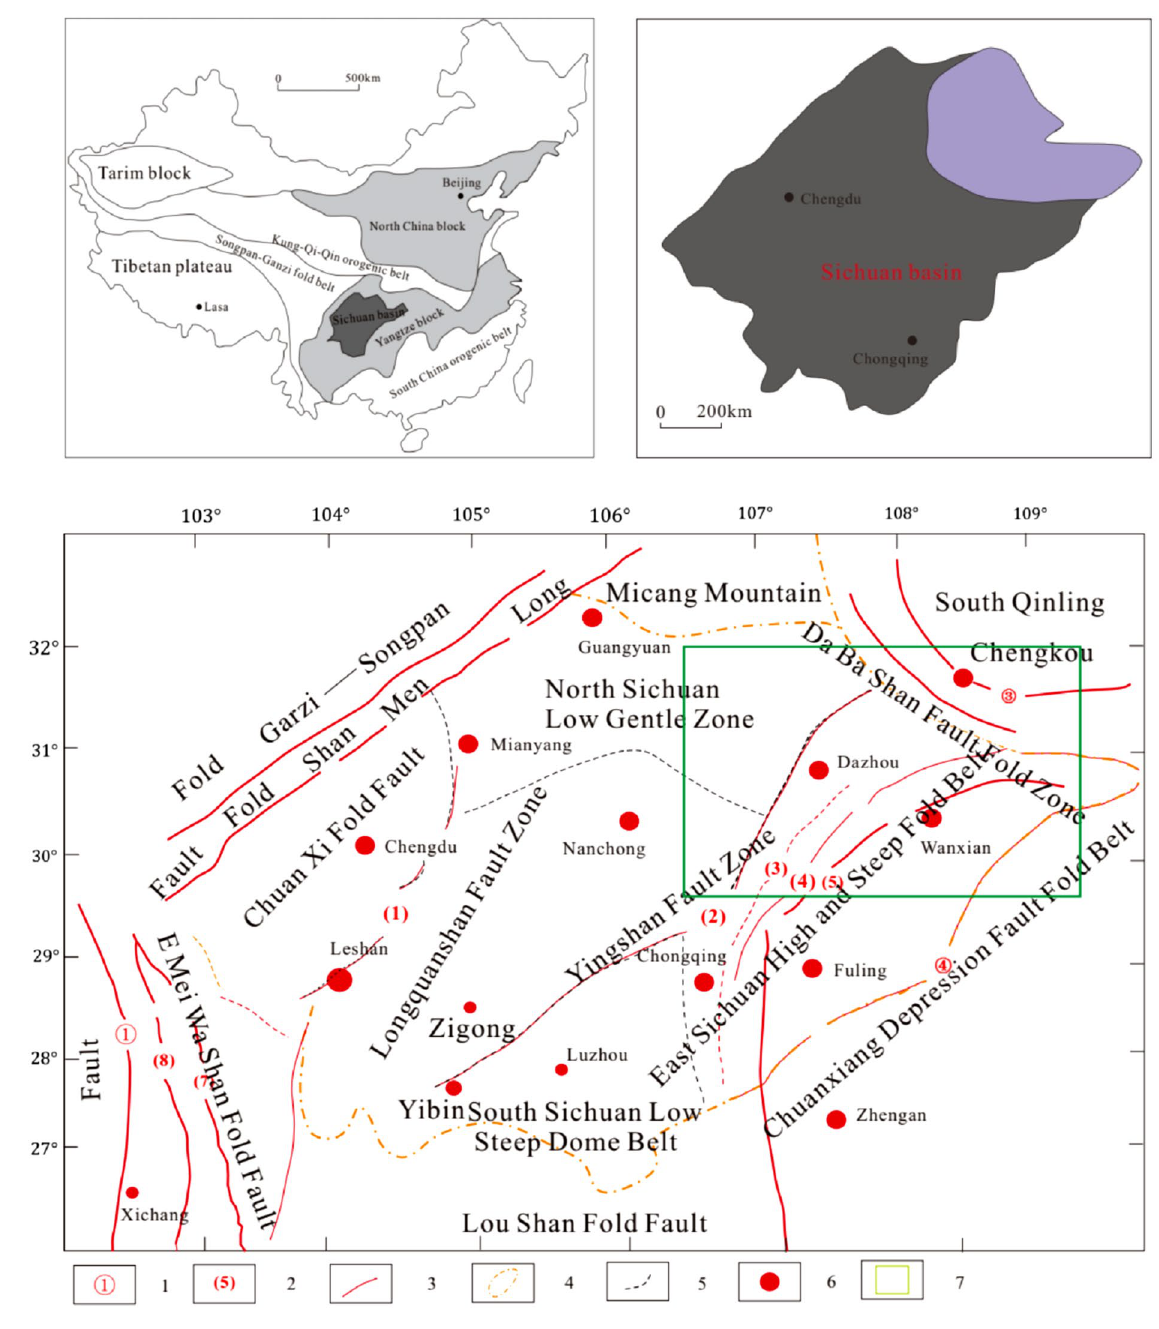
Fig. 1 Regional structural map of Sichuan